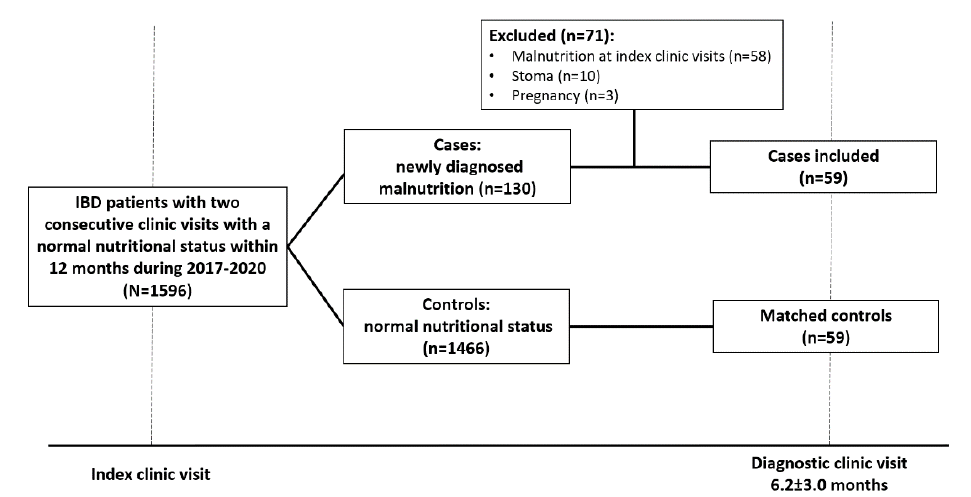
Figure 1. Data collection timeline and flowchart of study population selection.